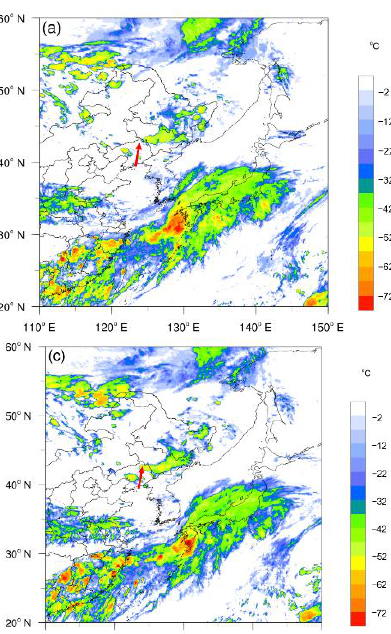
Figure 2. ( a ) Potential height (shaded areas, dagpm) and horizontal winds at 500 hPa; ( b ) temperature (shaded areas, ◦ C) and horizontal winds at 500 hPa; ( c ) potential height (shaded areas, dagpm) and horizontal winds at 850 hPa; ( d ) pressure (shaded areas, hPa) and horizontal winds at sea level at 08:00 LST on 3 July 2019. A full bar is 4 m s − 1 .